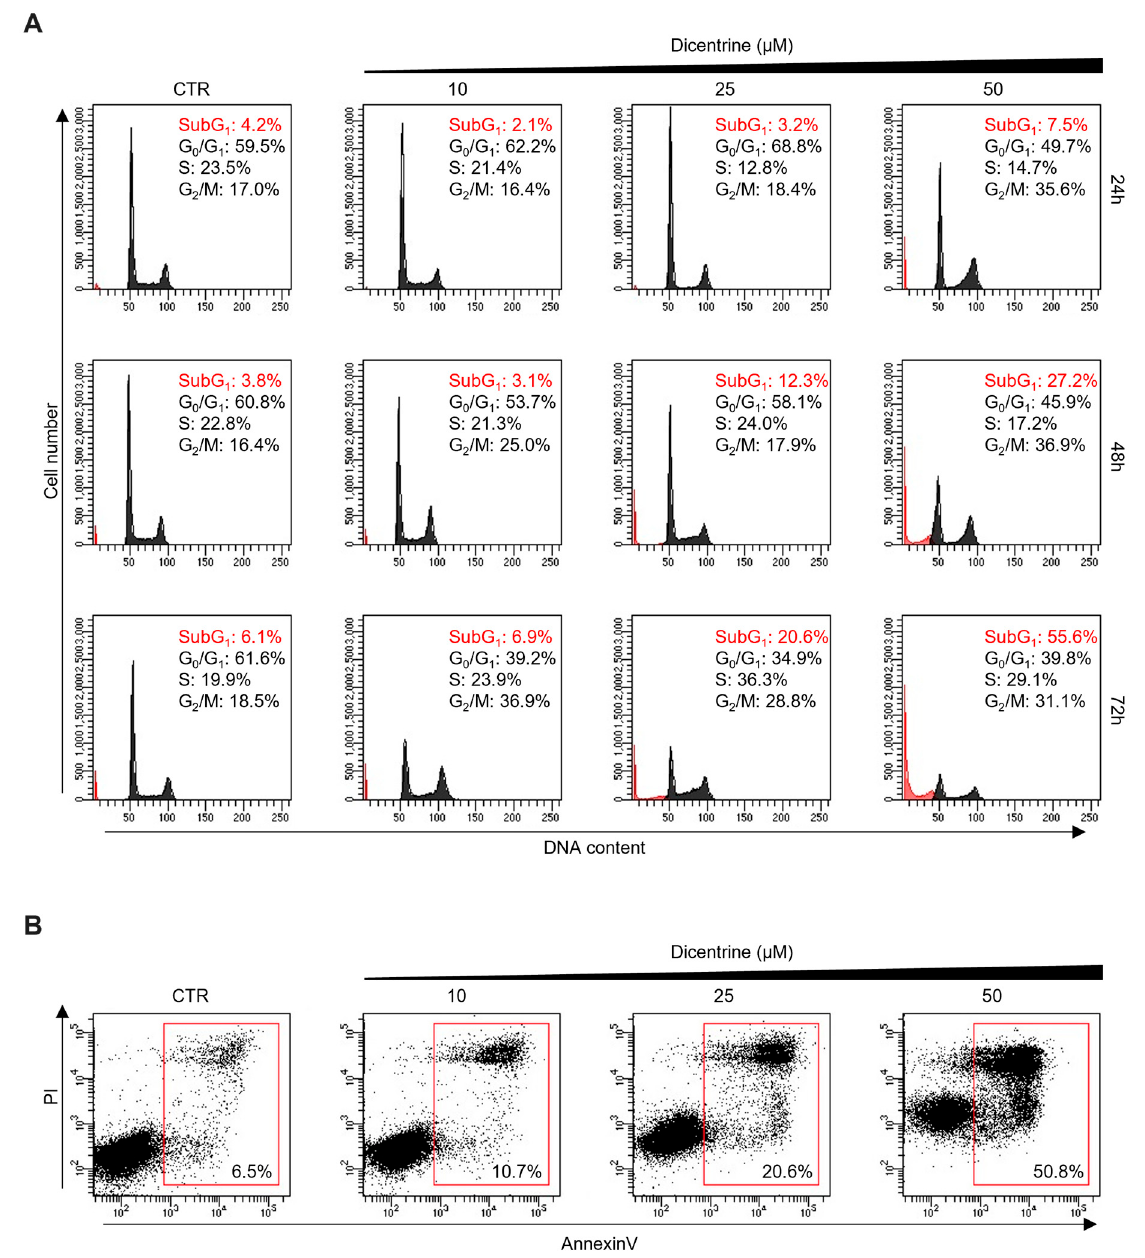
Figure 10. Dicentrine affects the cell cycle and induces apoptosis in cancer cells. HeLa cells were treated with DMSO (negative control) or increasing doses of Dicentrine (10, 25, 50 µ M) for the indi- cated times and then processed for flow cytometry analysis. ( A ) Cells were stained with propidium iodide (PI), and an analysis of the cell cycle was performed. Quantification of the percentage of cells in subG 1 and G 2 /M phases are reported in red and in black, respectively. ( B ) Two-dimensional scatter plots of Annexin V analysis performed on HeLa cells untreated or treated with growing doses of Dicentrine (10, 25, 50 µ M) for 72 h. Red boxes evidence the populations of Annexin V-positive cells. One representative image is shown for each experiment.